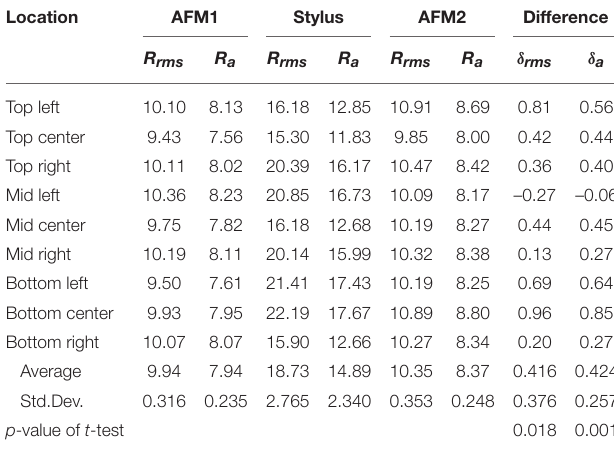
TABLE 2 | The root mean square R rms and the mean roughness R a for 9 patches of the a-C sample at 3 rounds of measurements, all measurements are in nm,